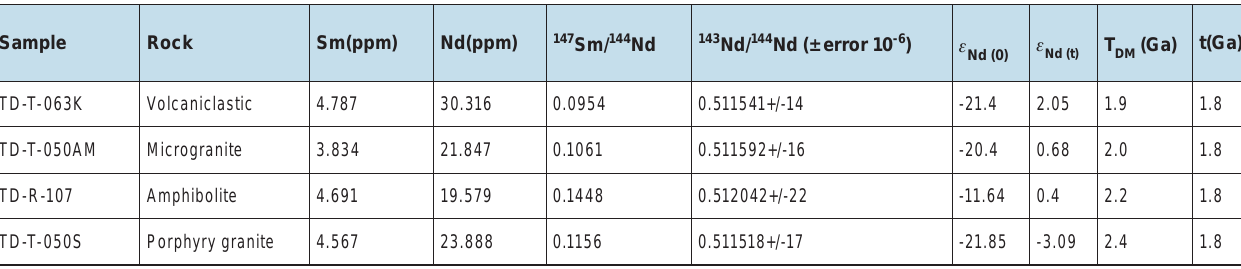
TABLE 3 - Whole rock Sm-Nd analyses of the Volcanic Domain.